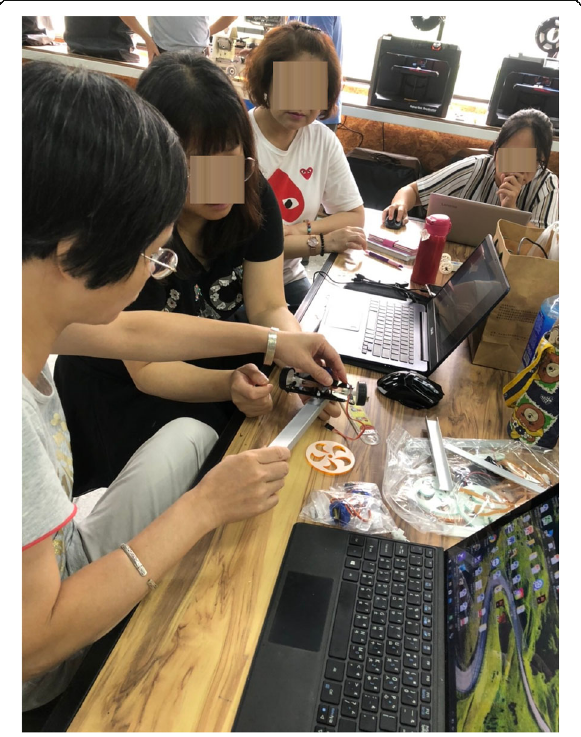
Fig. 10 Teachers discussed with each other during the